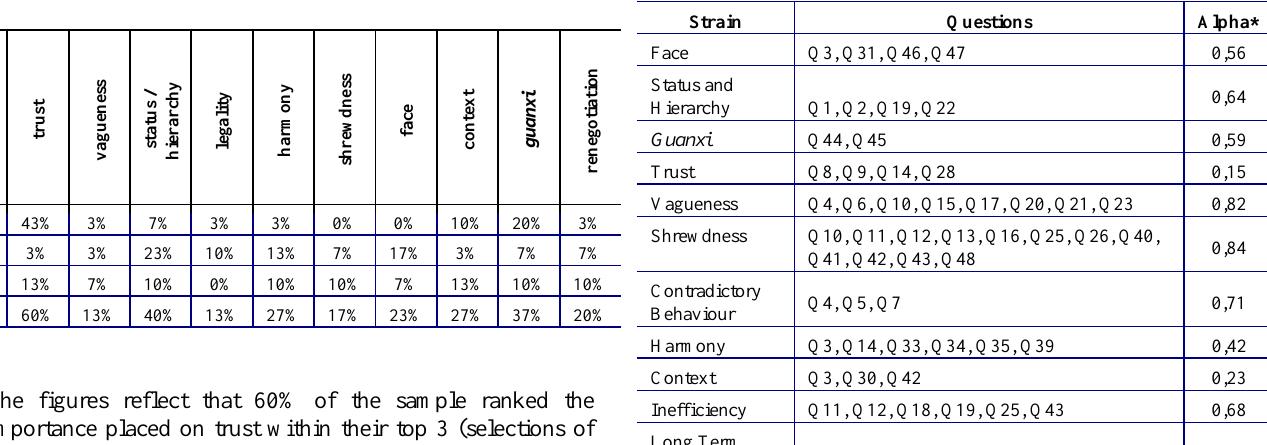
Table 3. Summary of Cronbach’s